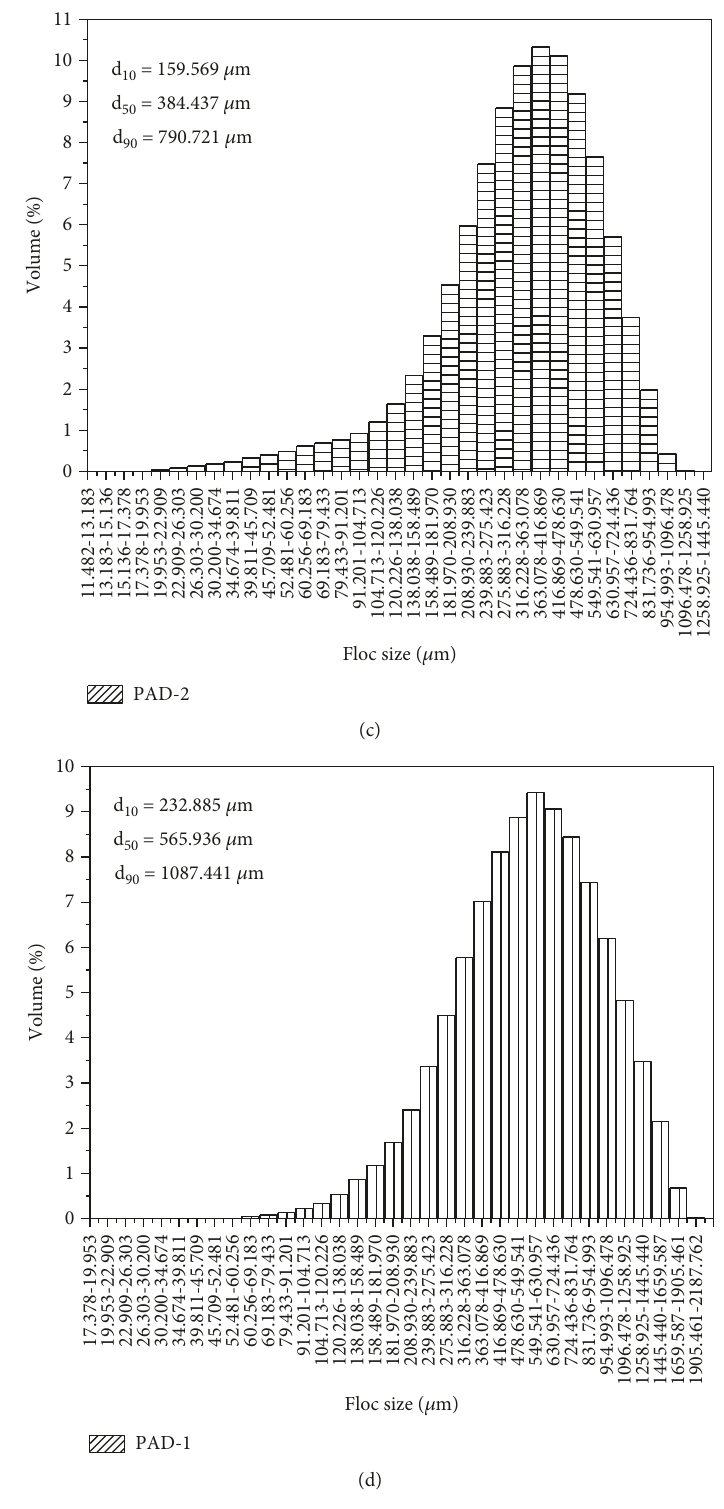
Figure 14: Sludge fl oc size distribution for (a) PAM, (b) CCPAM, (c) PAD-2, and (d)